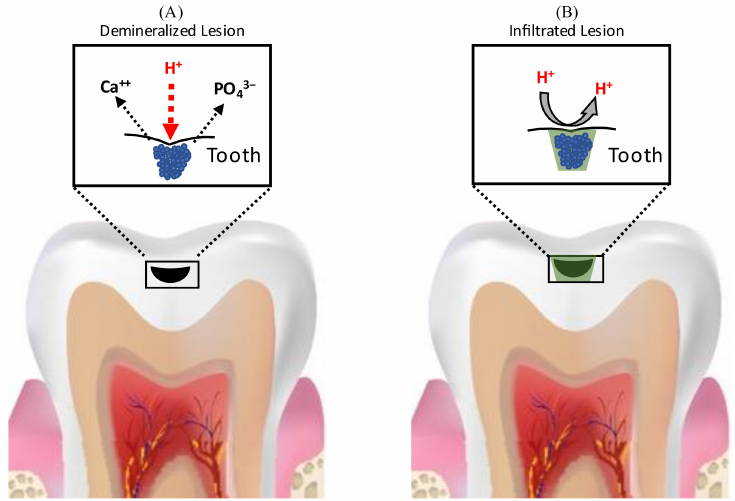
Figure 5. Schematic representation of caries-arresting effect of resin infiltration. ( A ) Demineralization of enamel due to acids, resulting in the formation of enamel porosities ( B ) Resin infiltrants penetrate the demineralized enamel lesions and occlude the inter-crystalline spaces after polymerization, resulting in the formation of a polymer framework that acts as a barrier for hydrogen ions, inhibiting further demineralization and arresting the progress of